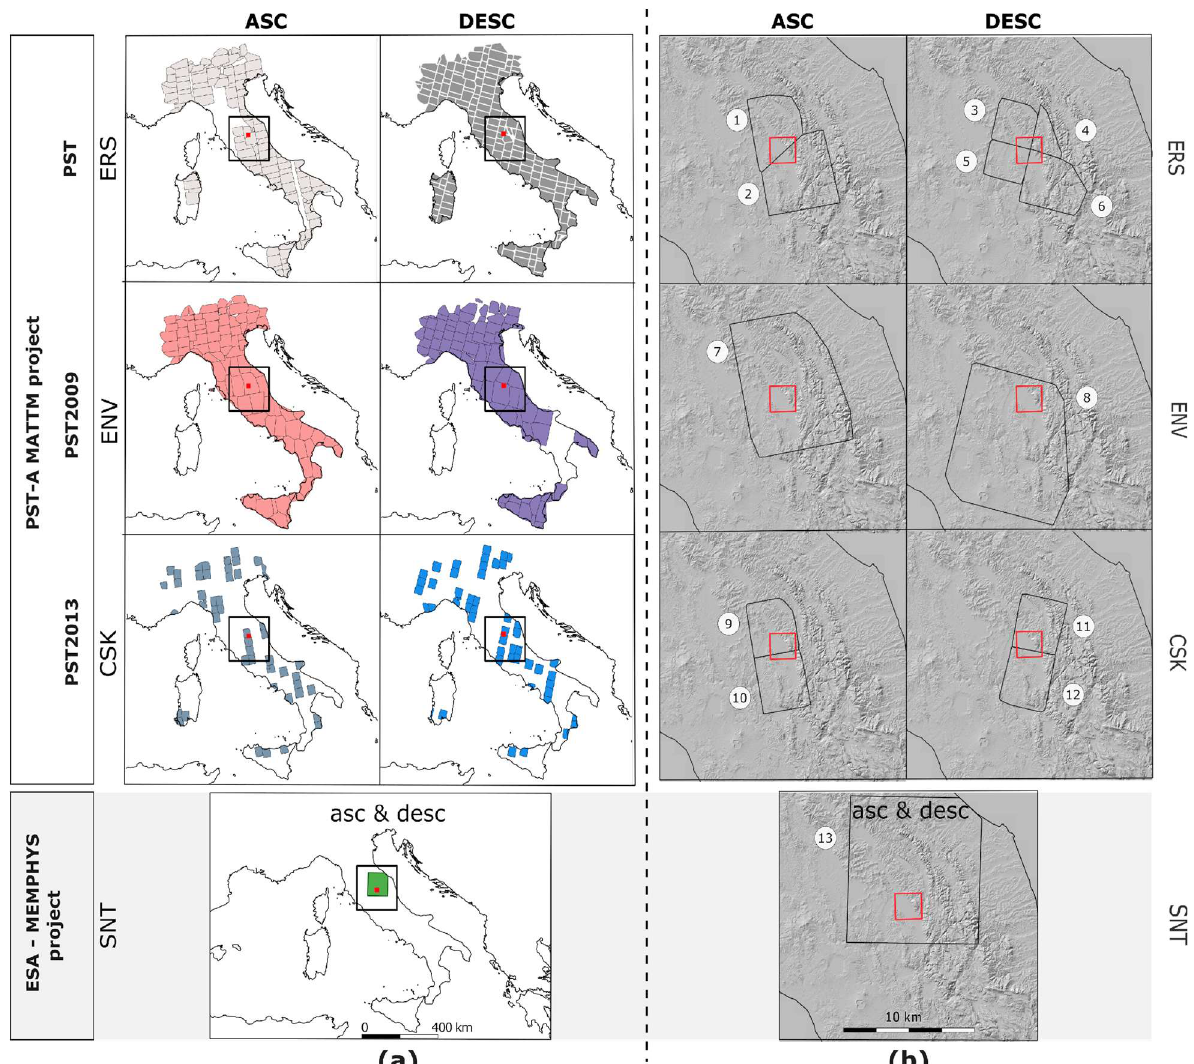
Figure 1. ( a ) The PS data on the Italian peninsula provided by the PST-A project (the first three rows are the data from the 1992–2014 ERS, ENV and CSK missions) were organized in clusters of ascending (ASC) and descending (DESC) orbits. In the last row, the Italian area covered by PS is derived from the SNT mission in both ascending and descending satellite orbit data, processed by the ESA-MEMPHIS project. See Table 1 for the statistics. The black box indicates the Figure 1b area. ( b ) The red box indicates the NUB study area, and the numbers in the white circles identify the clusters’ names (Table 2 and 3) used in this work. In the background, the central Italy orography and black boxes are the clusters of PS used in this work.